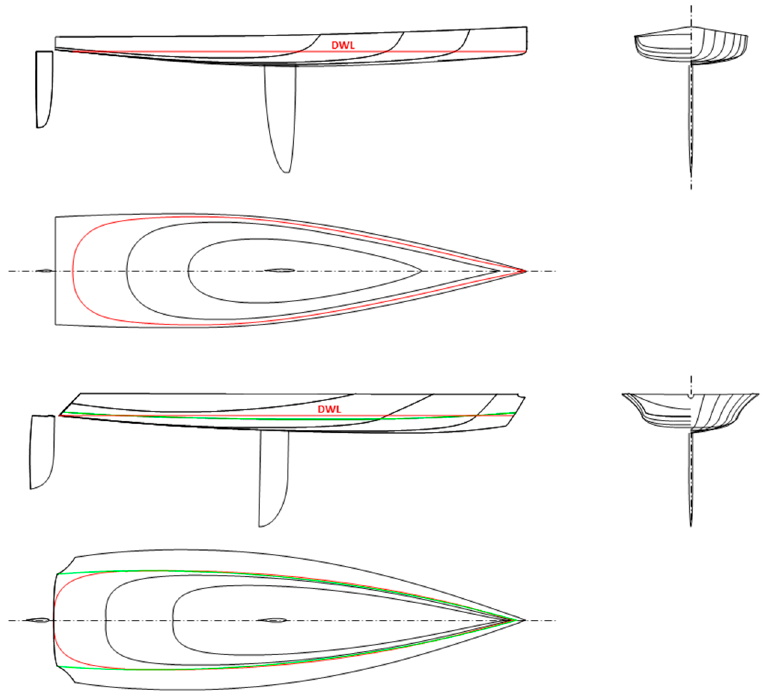
Figure 15. Hull design of LED ( top ) and TryAgain ( bottom ).